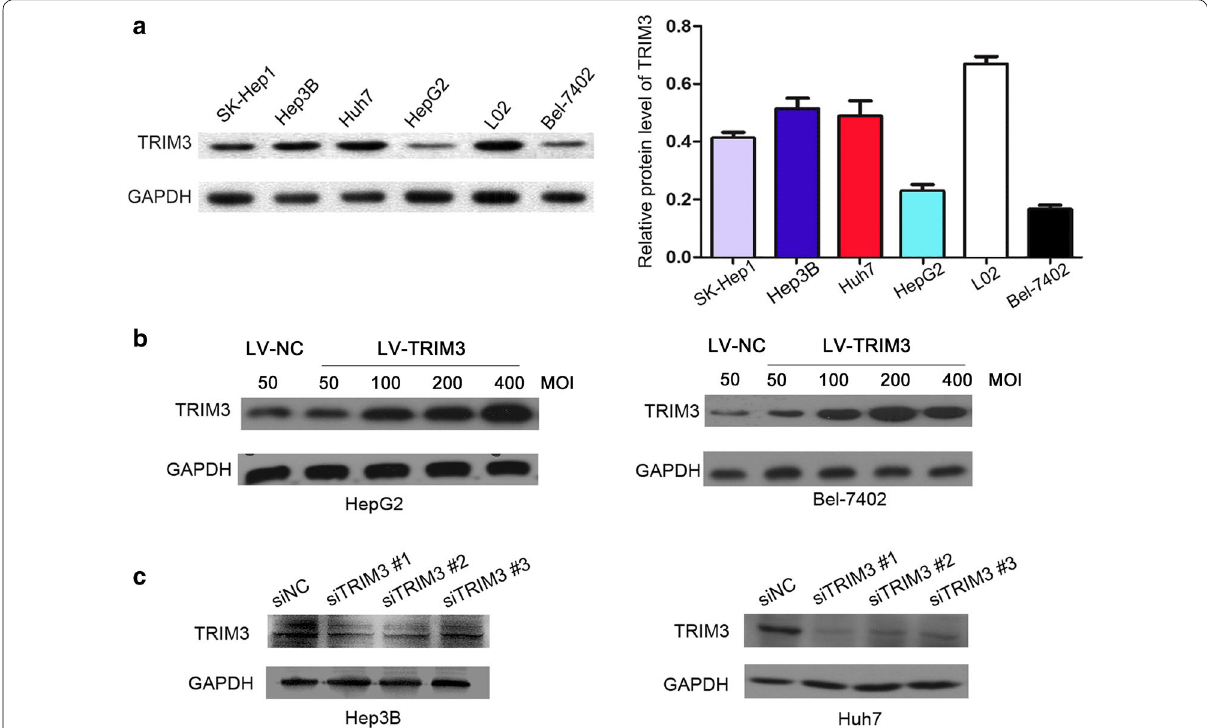
Fig. 1 The expression of tripartite motif‑containing 3 (TRIM3) protein in liver cancer cell lines evaluated with Western blotting. a Compared with the normal liver cell line L02, Bel‑7402 and HepG2 cell lines have much lower levels of TRIM3. Relative protein levels of TRIM3 in different cell lines are shown as mean standard deviation (SD). Glyceraldehyde 3‑phosphate dehydrogenase (GAPDH), was used as internal reference. b TRIM3 ± expression in HepG2 and Bel‑7402 cells infected with lentiviruses expressing TRIM3 (LV‑TRIM3) at multiplicities of infection (MOIs) of 50, 100, 200, and 400 was higher than that in cells infected with negative control vector (LV‑NC, MOI of 50) on day 16 after infection. HepG2 and Bel‑7402 cells infected with lentiviruses at an MOI of 200 were selected to be used in function assays. c Among the three TRIM3‑targeted small interfering RNAs (siTRIM3), siTRIM3 #1 and siTRIM3 #2 showed higher knockdown efficiencies after 48‑h transfection. siNC, negative control small interfering